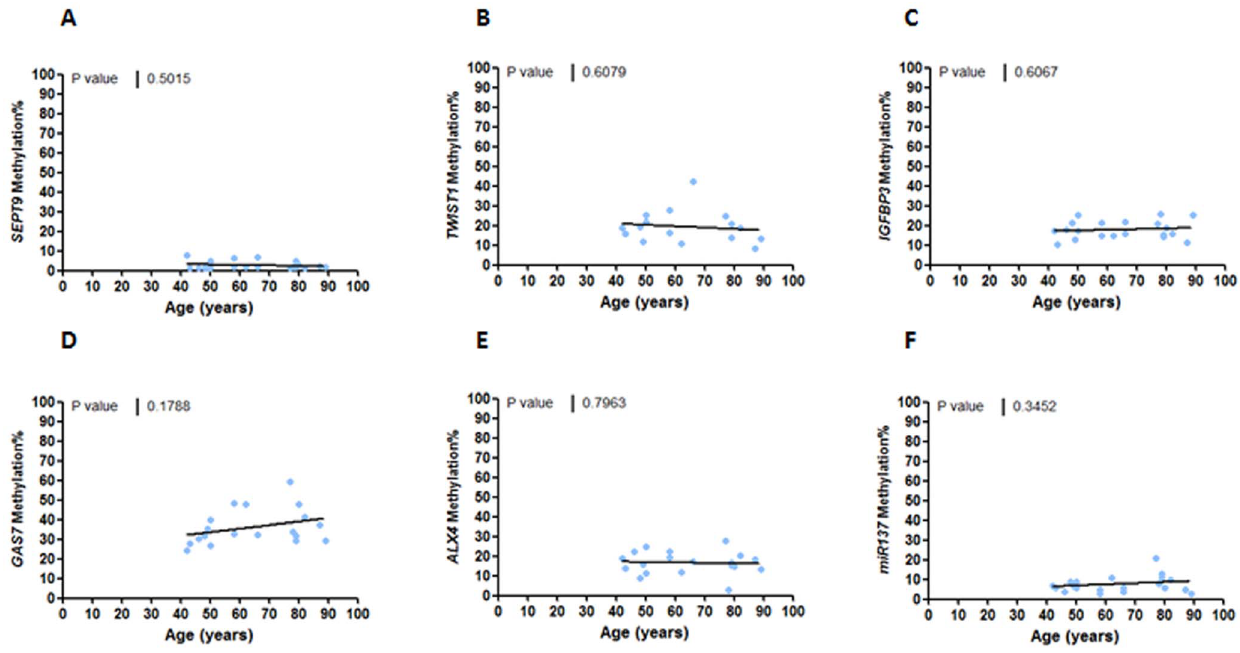
Figure 4. Correlation between colon mucosa methylation and age of healthy controls. linear regression analysis comparing tumor methylation of sept9 (a), twist1 (b), igfbp3 (c), alx4 (d), gas7 (e) and mir137 (f) vs age of the healthy control patients (years).